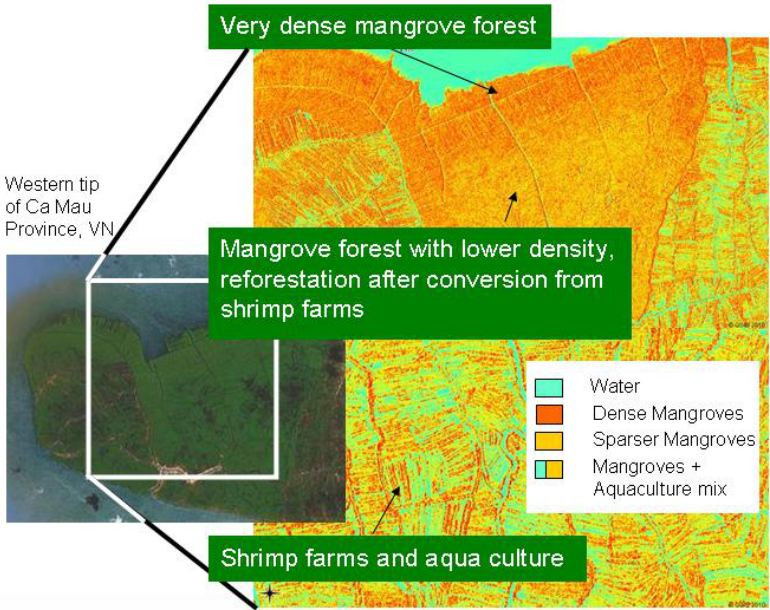
Figure 6. Mangrove density and class mixture information based on Envisat ASAR and TerraSAR-X data for the western tip of Ca Mau Province, Vietnam, December